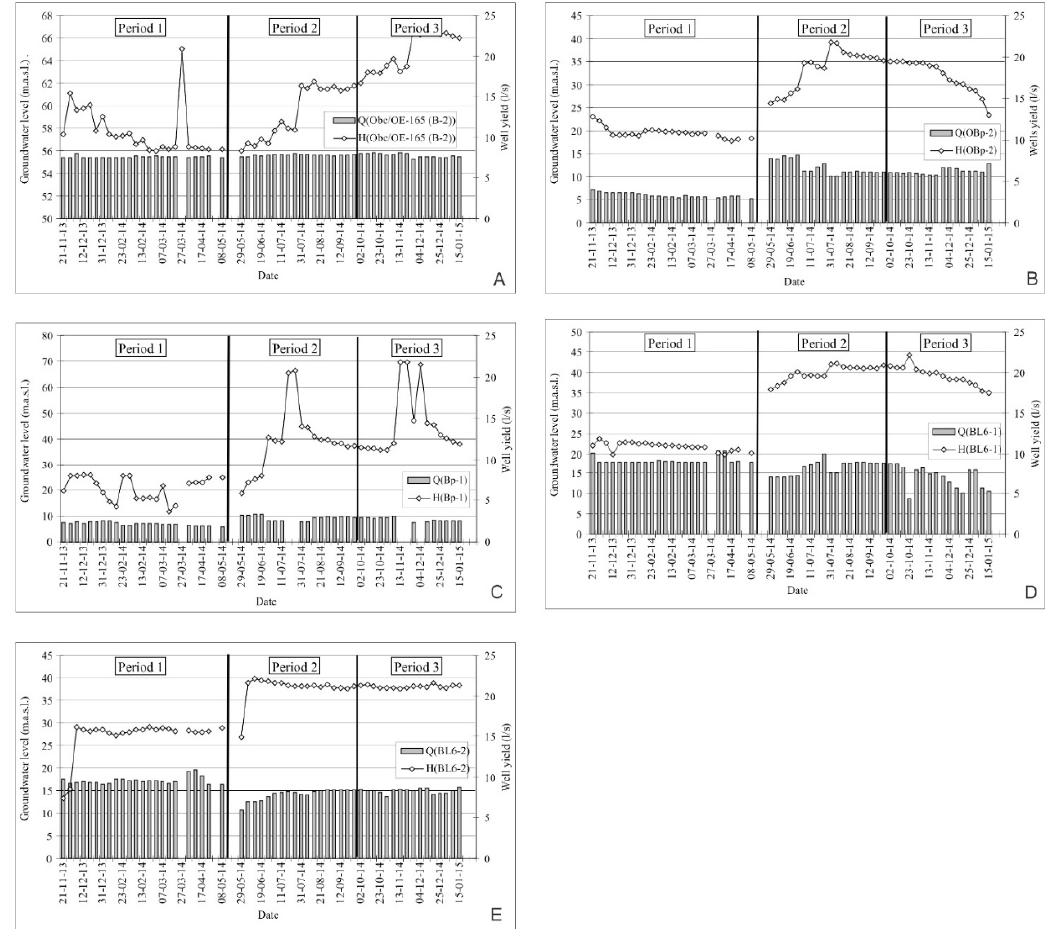
Figure 5. Histograms and water level plots of some of the wells of the Kalenić source from 21 November 2013 to 15 January 2015: ( A ) Obc-OE-165 (B-2); ( B ) OBp-2; ( C ) Bp-1; ( D ) BL6-1; ( E ) BL6-2.